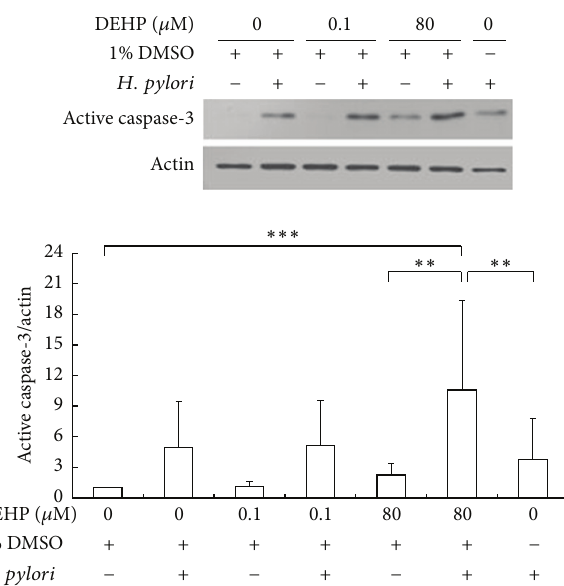
Figure 4: DEHP and H. pylori increased active form of caspase-3 protein expression after 18-hour treatment. Statistical significance was analyzed by one-way ANOVA and post hoc LSD test ( ∗∗ 𝑃 < 0.05 , ∗∗∗ 𝑃 < 0.01 , 𝑁 = 4 ).